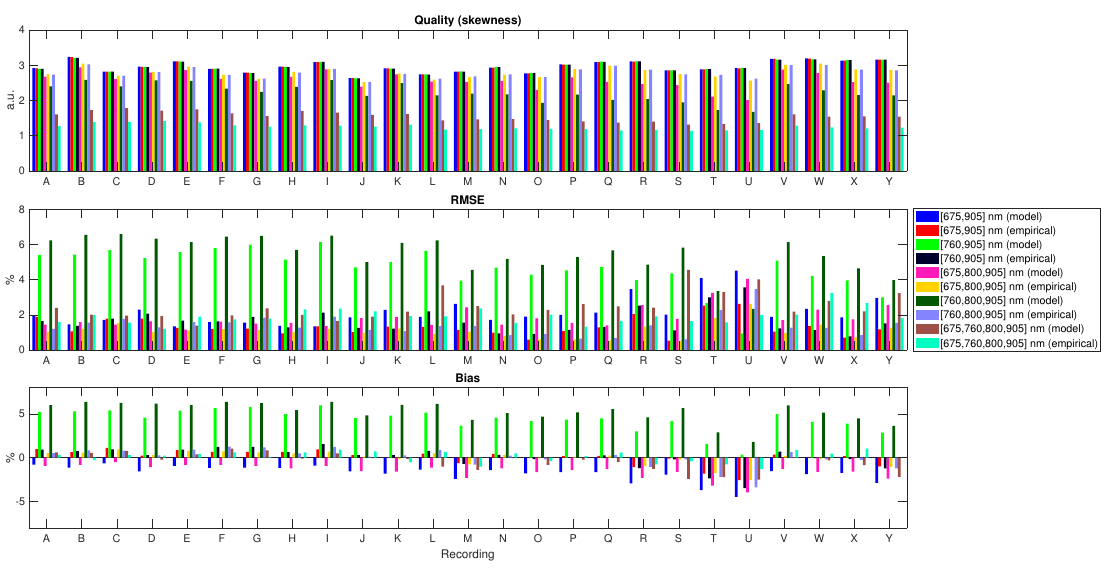
Figure 10. An overview of the evaluation metrics (pulse) quality, root-mean-square error (RMSE) and bias for all recordings in dataset using the model-based and empirically-derived calibration models. The results are calculated for two dual-wavelength and three-wavelengths combinations, and the derived four-wavelengths